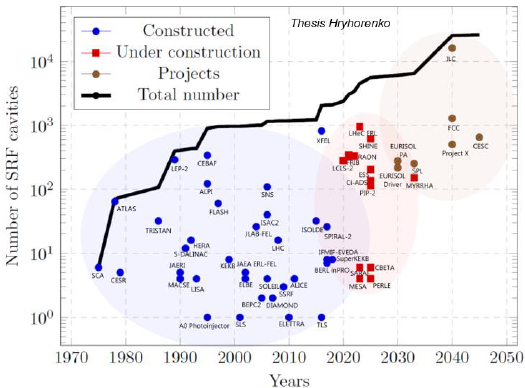
Figure 2. Number of SRF cavities versus year